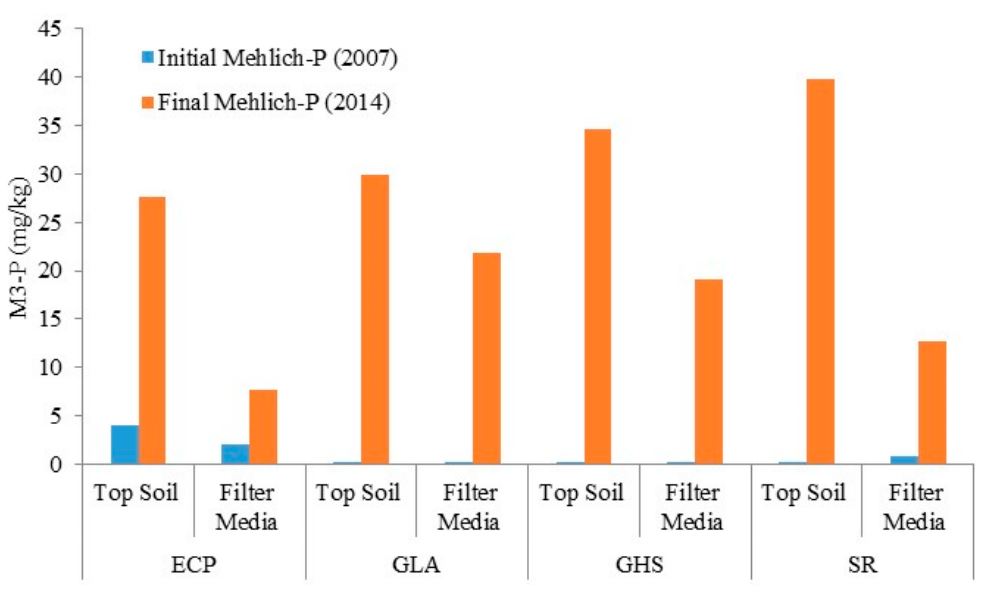
Figure 11. M3-P mass concentrations in top soil and filter media in 2007 and 2014.